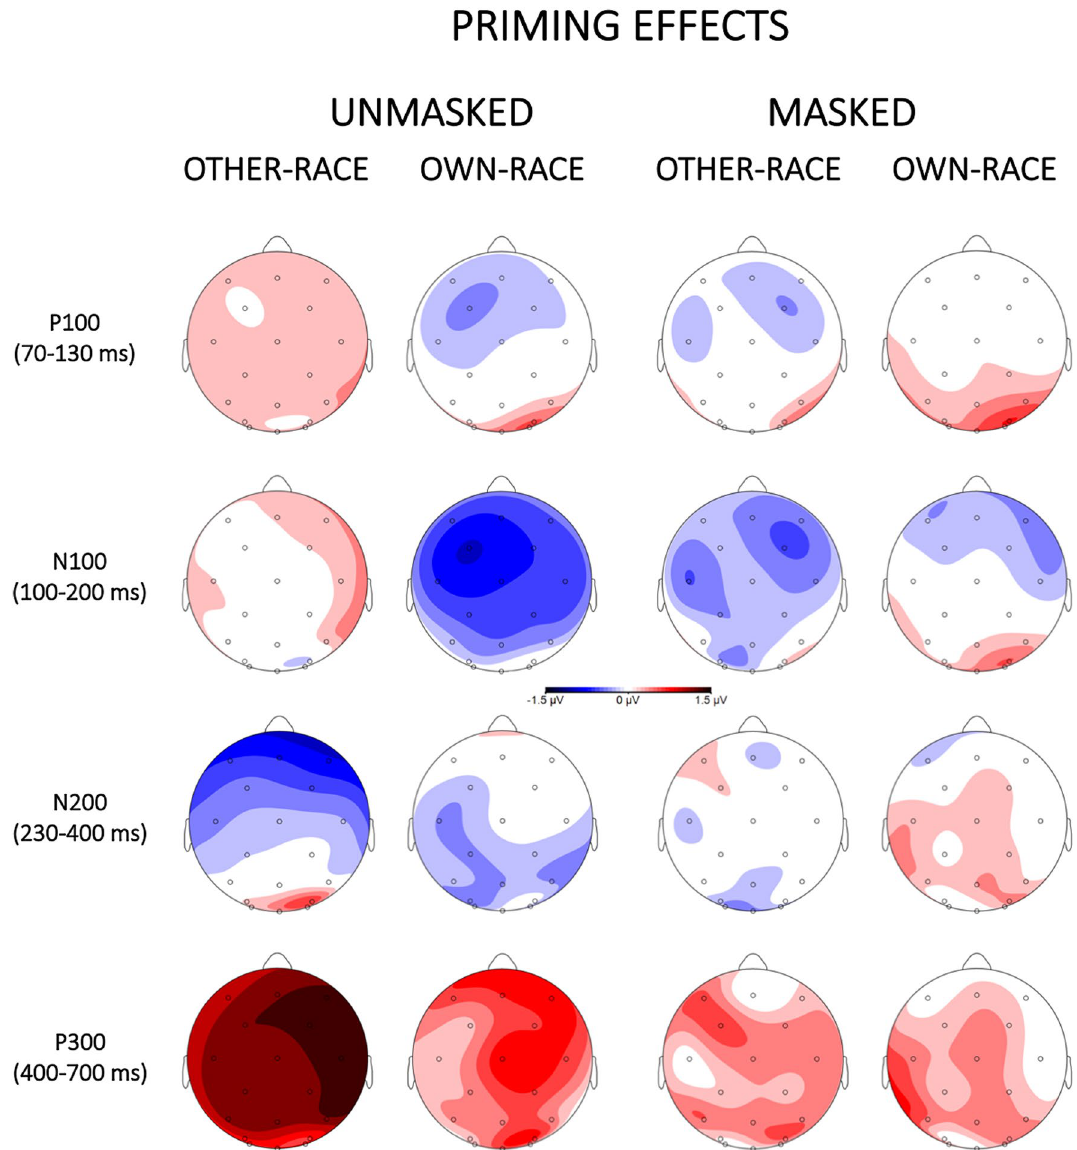
Figure 5. Topographical scalp distributions for target face separately for the unmasked (left panel) and masked (right panel) procedures as a function of a function of prime-target identity (same vs different) and race (other- race vs own-race) in the four critical time windows, created by subtracting same other-race and own-race conditions from different other-race and own-race ones,